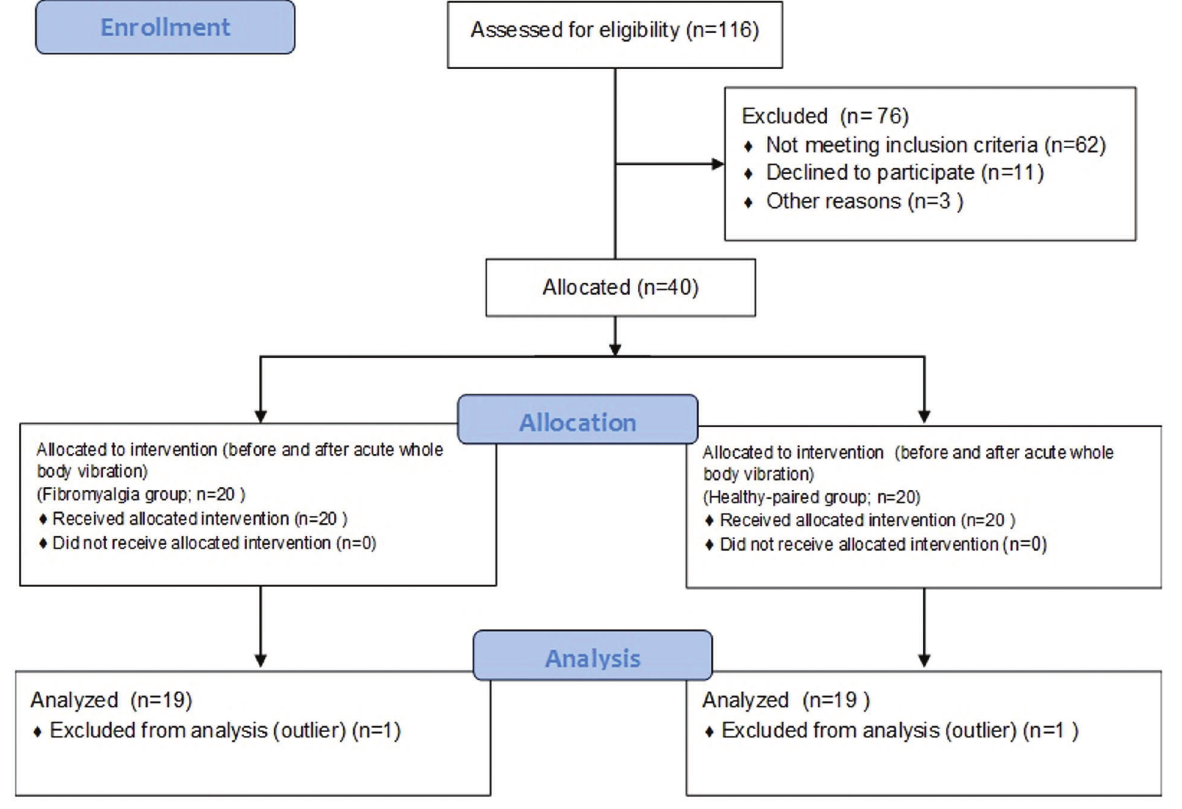
Figure 1. Study fl